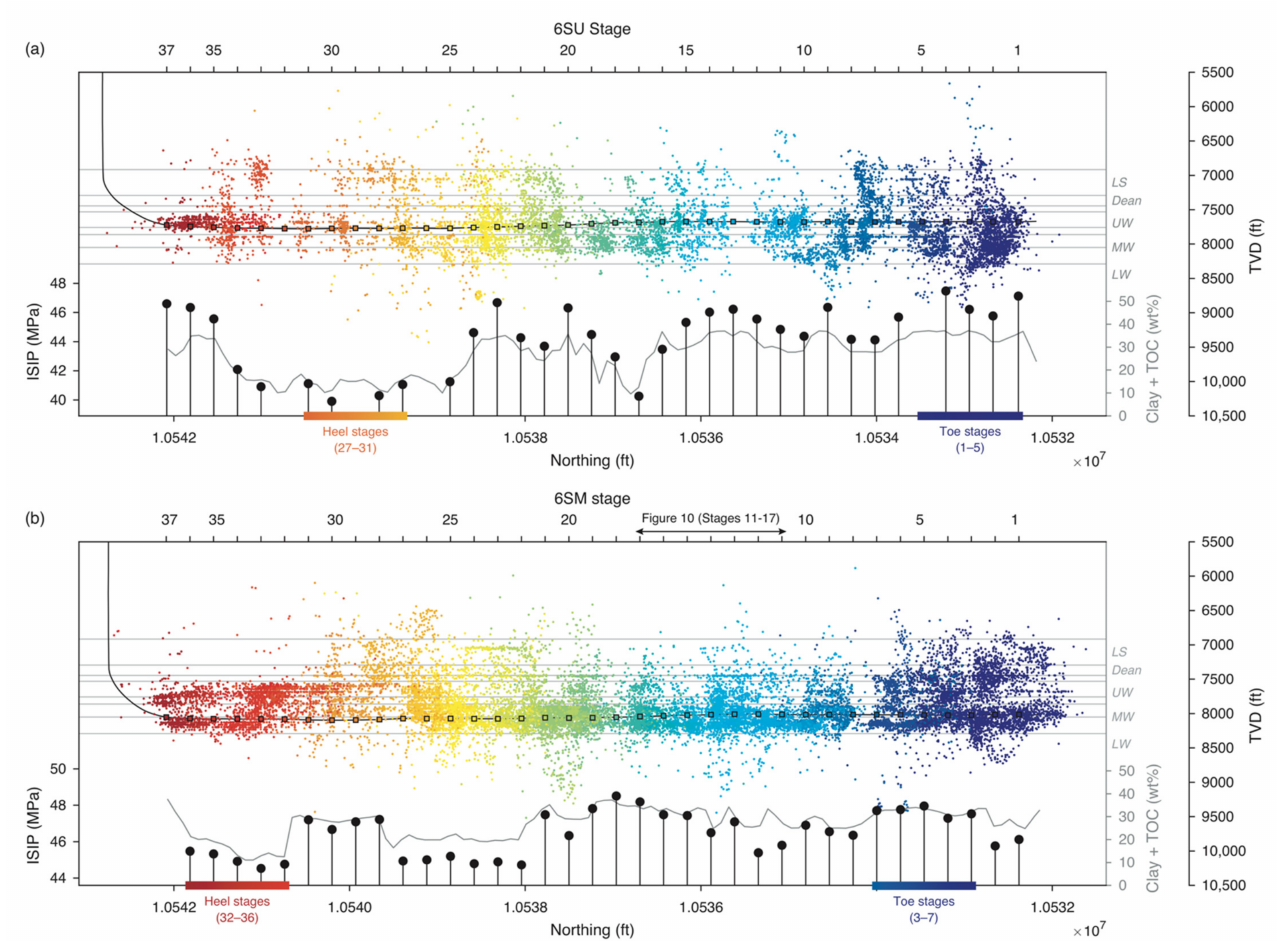
Figure A5. Horizontal profiles showing microseismicity, composition, and fracture stage instantaneous shut-in pressures (ISIPs) for wells ( a ) 6SU and ( b ) 6SM. Microseismic events colored by stage, ISIPs (black points), and clay + TOC (grey line) plotted over the well trajectory (black line). Colored squares represent stage locations. Clay + TOC values are interpolated from the compositional log in the 7SU pilot